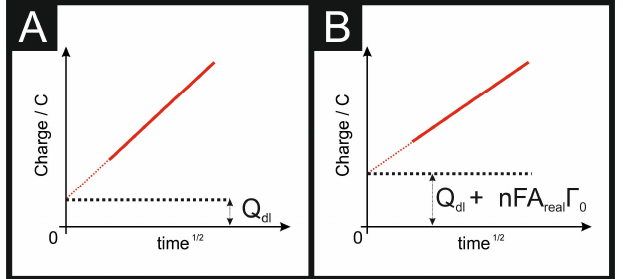
Figure 3. Representation of CC (charge vs. time 1/2 ) for a non-adsorbed outer-sphere probe ( A ) and for an adsorbed inner-sphere probe ( B ). Note that, in ( A ), the intercept is not truly zero due to the contribution of Q dl (see Equations (6) and